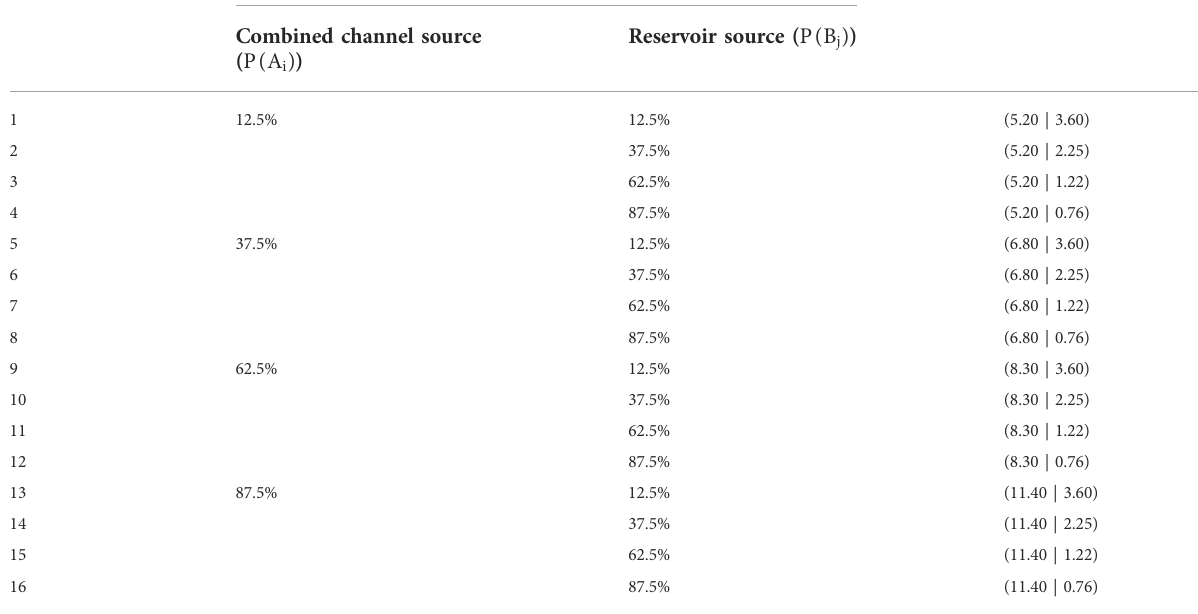
TABLE 4 Water supply scheme settings under different encounter situations. Schemes